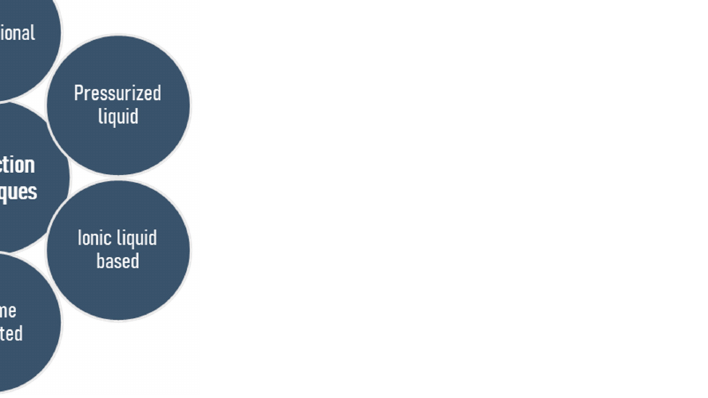
Figure 2. Conventional and modern procedures for the extraction of sulfated polysaccharides from marine algae.